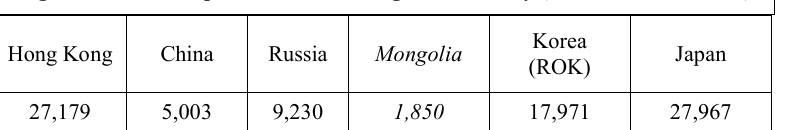
Fig. 3- GDP Per Capita with Purchasing Power Parity (in U.S. Dollars- 2003) 4